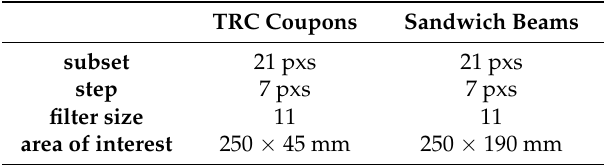
Table 3. Settings digital image correlation (DIC) analysis.